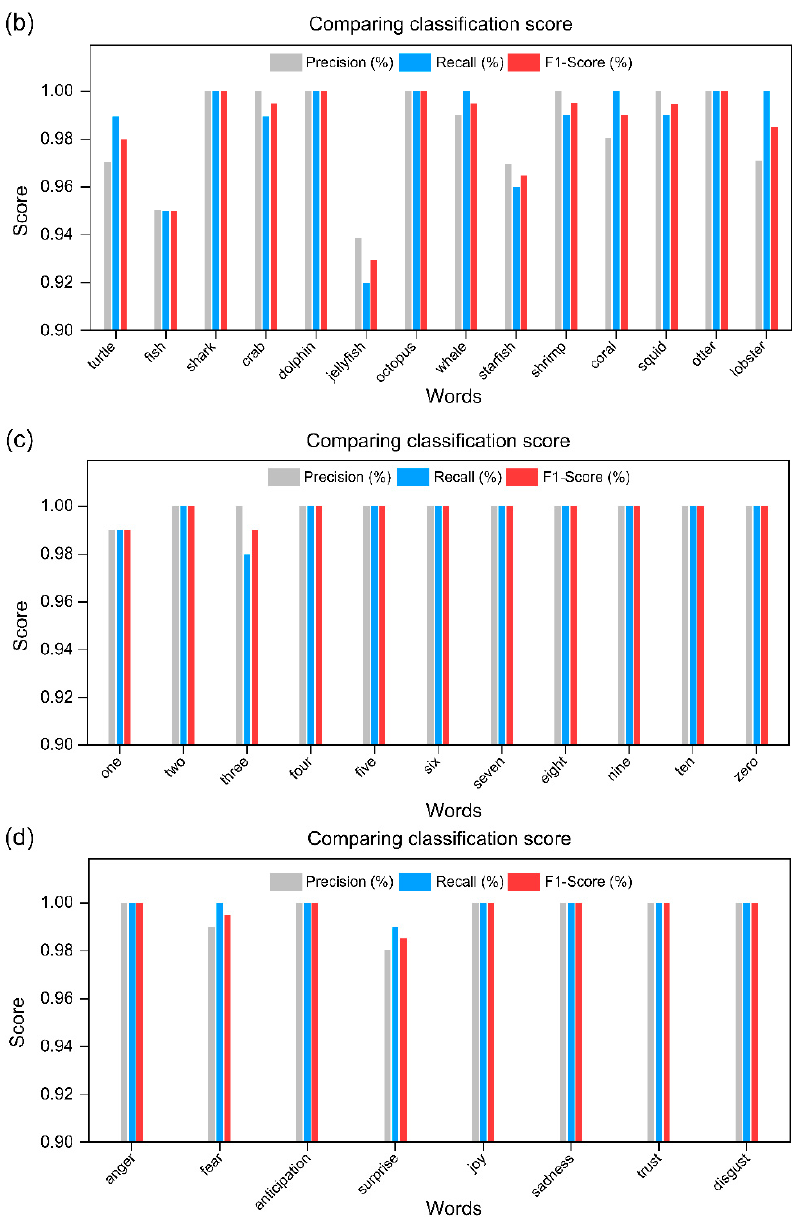
Figure 13. Comparing classification scores of the proposed model trained on 53 classes. ( a ) Control commands; ( b ) marine life; ( c ) number; ( d ) emotion.